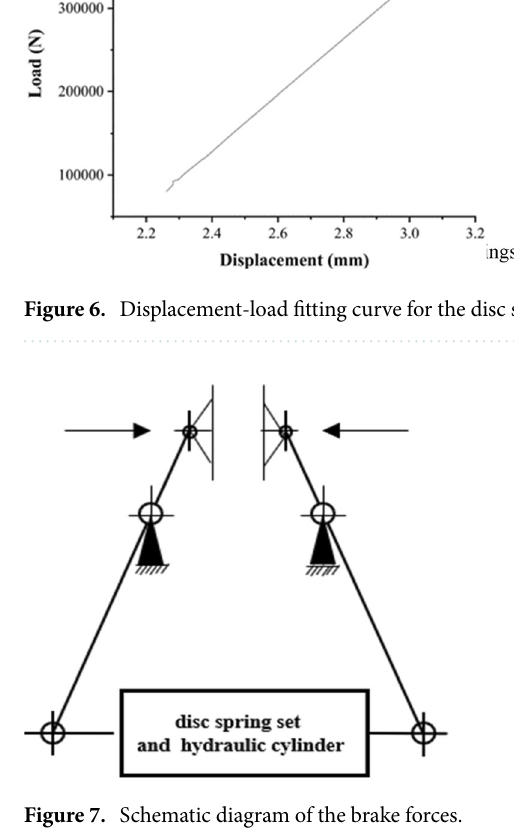
Figure 7. Schematic diagram of the brake forces.